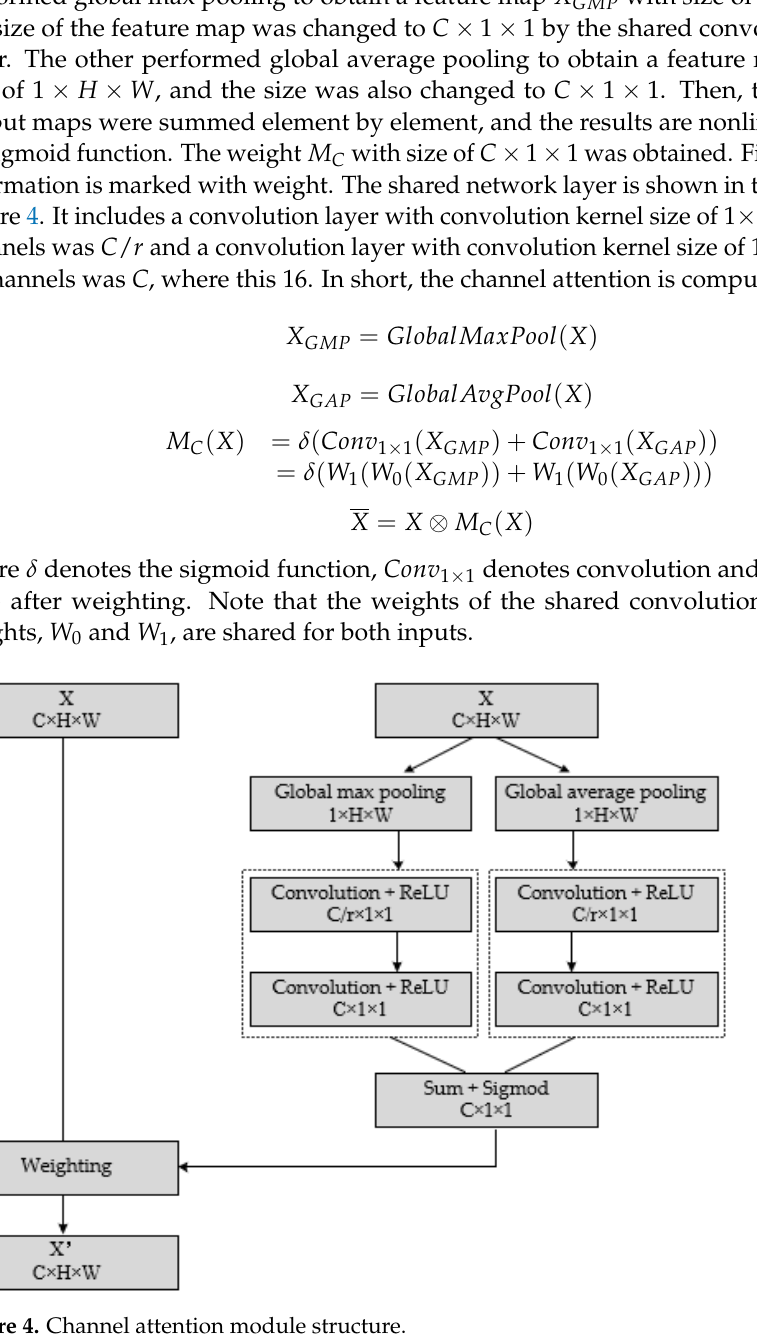
Figure 4. Channel attention module structure.